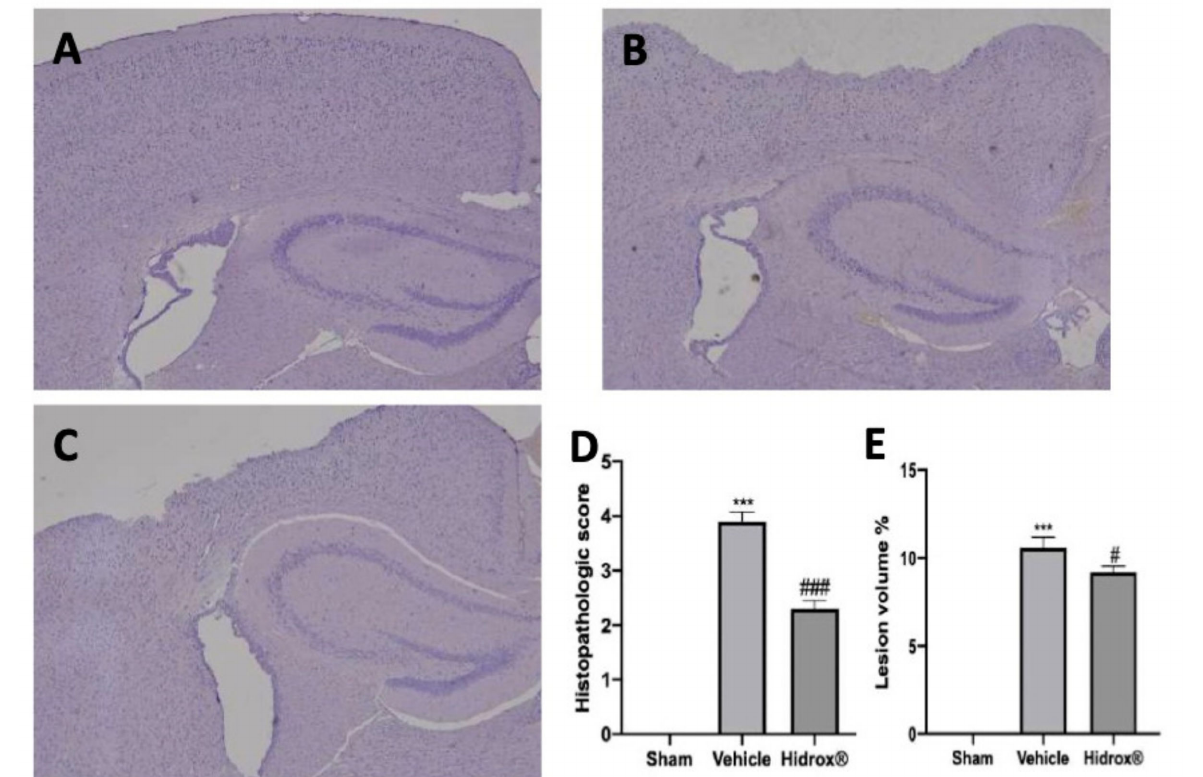
Figure 1. Hidrox ® administration reduced TBI-induced histological lesions. Histological analysis: Sham ( A ), Vehicle ( B ), Hidrox ® ( C ), Histopathological score ( D ), Lesion Volume % ( E ). For the analyses, n = 5 animals in each group were employed. ( C ) Results were analyzed by one-way ANOVA followed by a Bonferroni post-hoc test for multiple comparisons. Histopathological score ( D ): F(2,12) = 110.8, Lesion Volume % ( E ): F(2,12) = 139.6. A p -value of less than 0.05 was considered significant. # p < 0.05 vs. vehicle, *** p < 0.001 vs. sham, ### p < 0.001 vs.